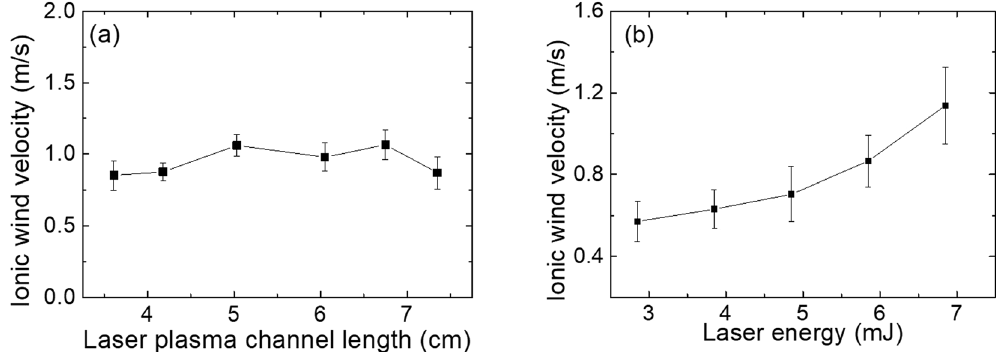
Figure 4. Measured ionic wind velocity as a function of ( a ) air plasma length outside the electrode and ( b ) the laser pulse energy. See more details in the text.